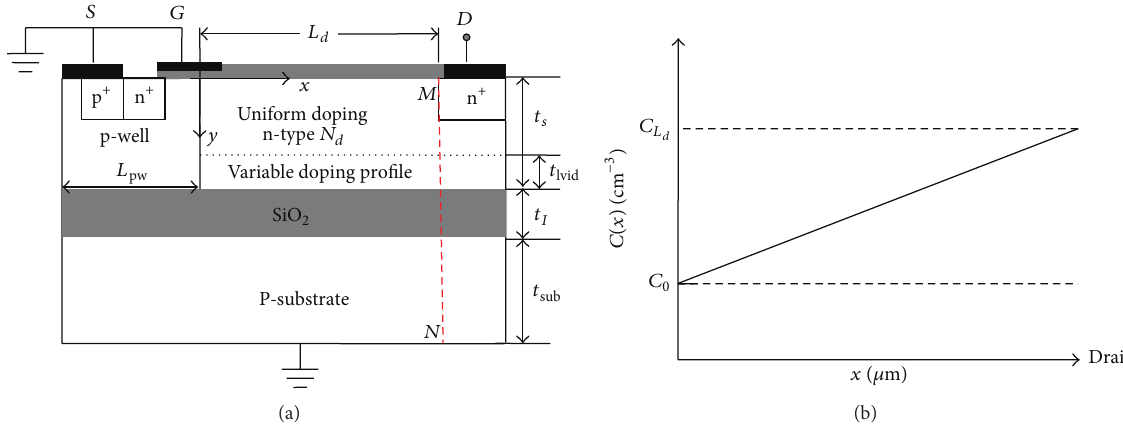
Figure 1: LVID SOI LDMOS. (a) Schematic cross-section; (b) the doping concentration of the LVID profile.